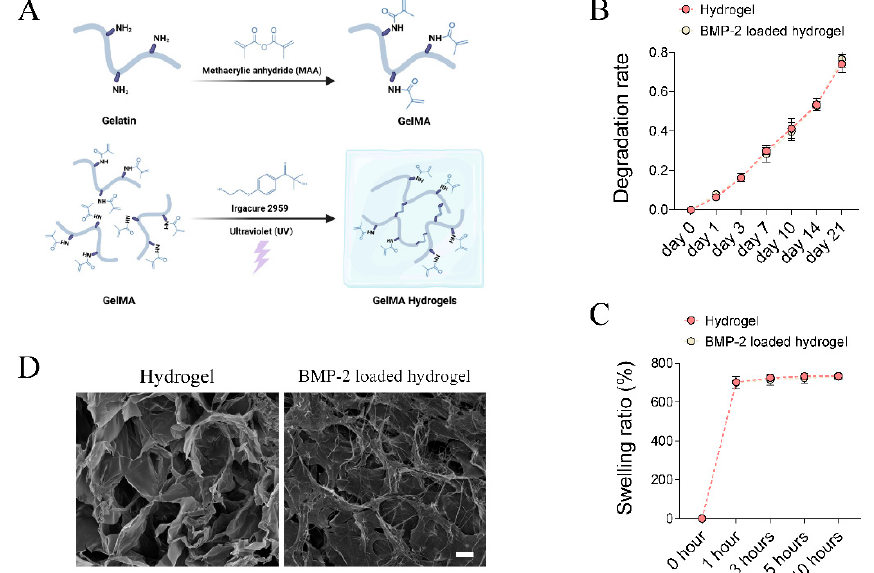
Figure 1. Fabrication and characterization of BMP-2-loaded hydrogel. ( A ) Schematic chart showing the synthesis of BMP-2-loaded GelMA hydrogel. ( B , C ) Quantitative analysis of the degradation rate and swelling ratio of GelMA and BMP-2-loaded GelMA hydrogels. ( D ) Representative SEM image of the microstructure of GelMA and BMP-2 loaded GelMA hydrogels. Scale bar 25 μ